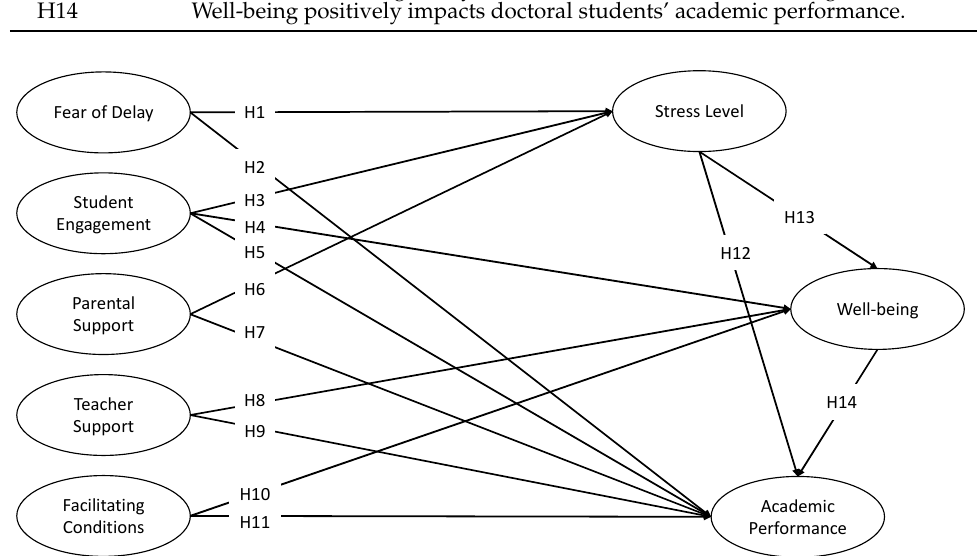
Figure 1. A proposed model for exploring factors affecting mathematics education doctoral students’ academic performance.